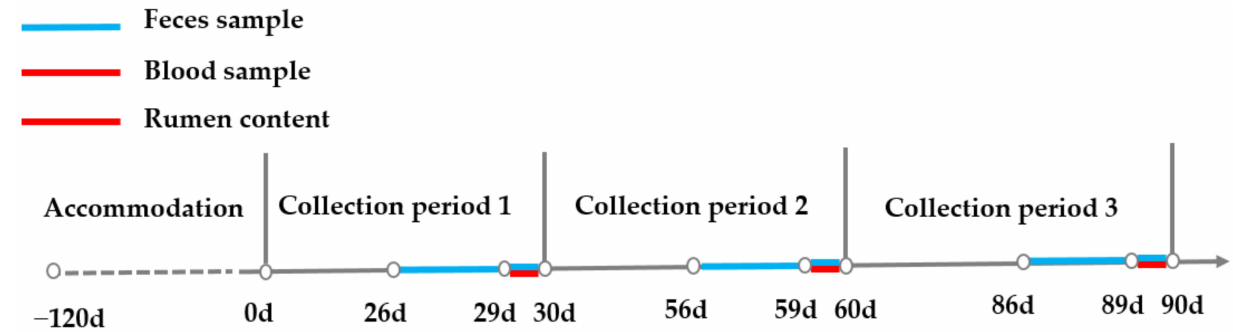
Figure 1. Illustration of sampling procedures. Notes: d indicates day and 0 d was the start of